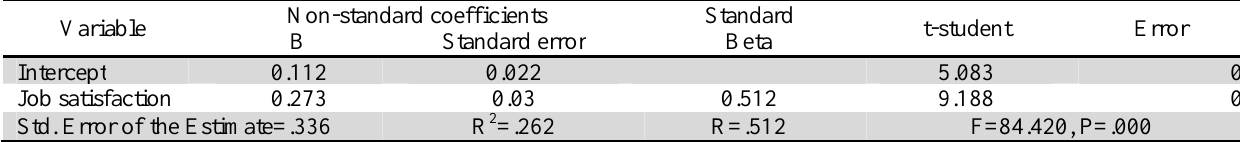
The results of regression analysis between job satisfaction and citizenship behavior Non-standard Variable